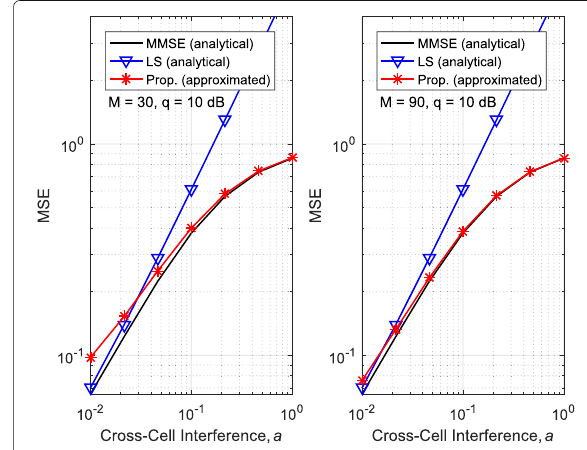
Fig. 3 Channel estimation MSE versus uplink pilot power